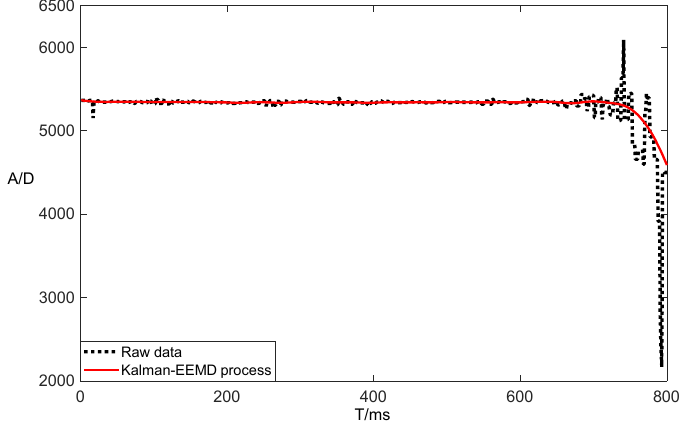
Figure 19. Comparison of the ninth-order fitting and Kalman-EEMD filtering effect.